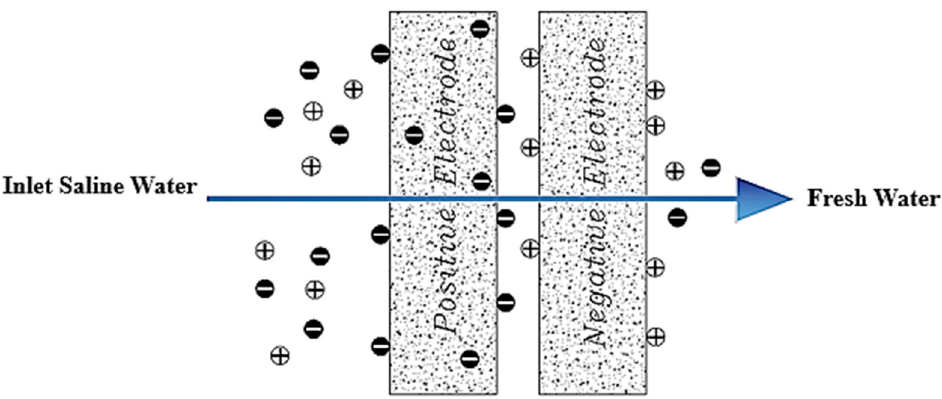
Figure 4. Flow-Through method in water desalination by CDI.